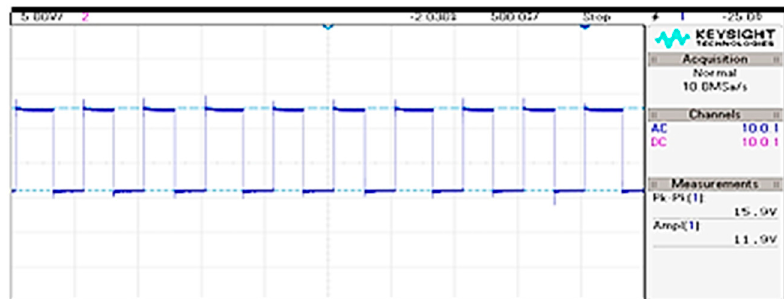
Figure 19. SPWM generation in dspace.